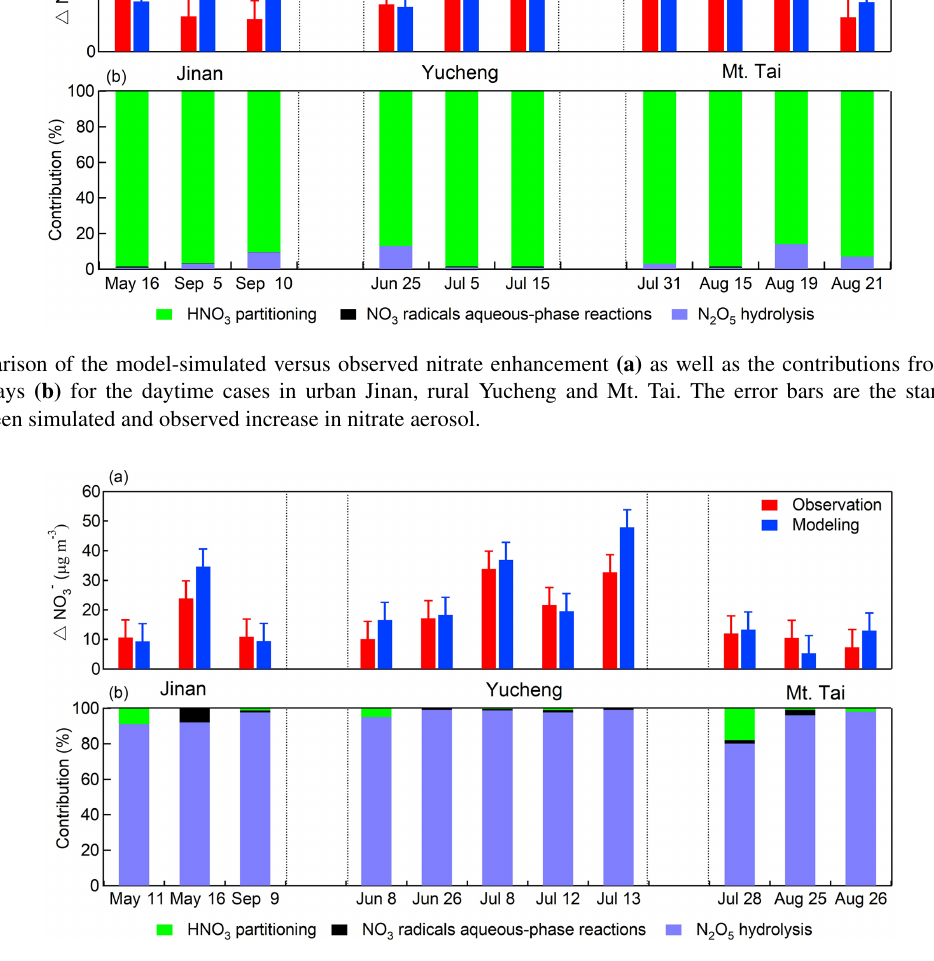
Figure 5. The same as Fig. 4 but for the selected nocturnal nitrate formation